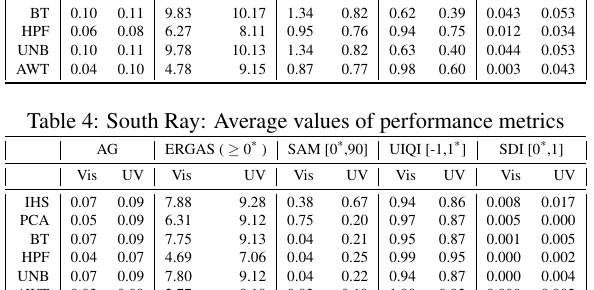
Table 5: Ina D: Correlation Coefficient (MS,DHRMS)